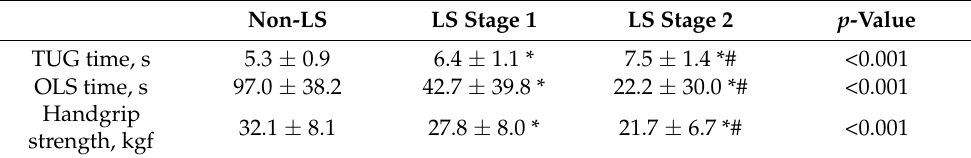
Table 3. Conventional functional motor measures for each LS group.